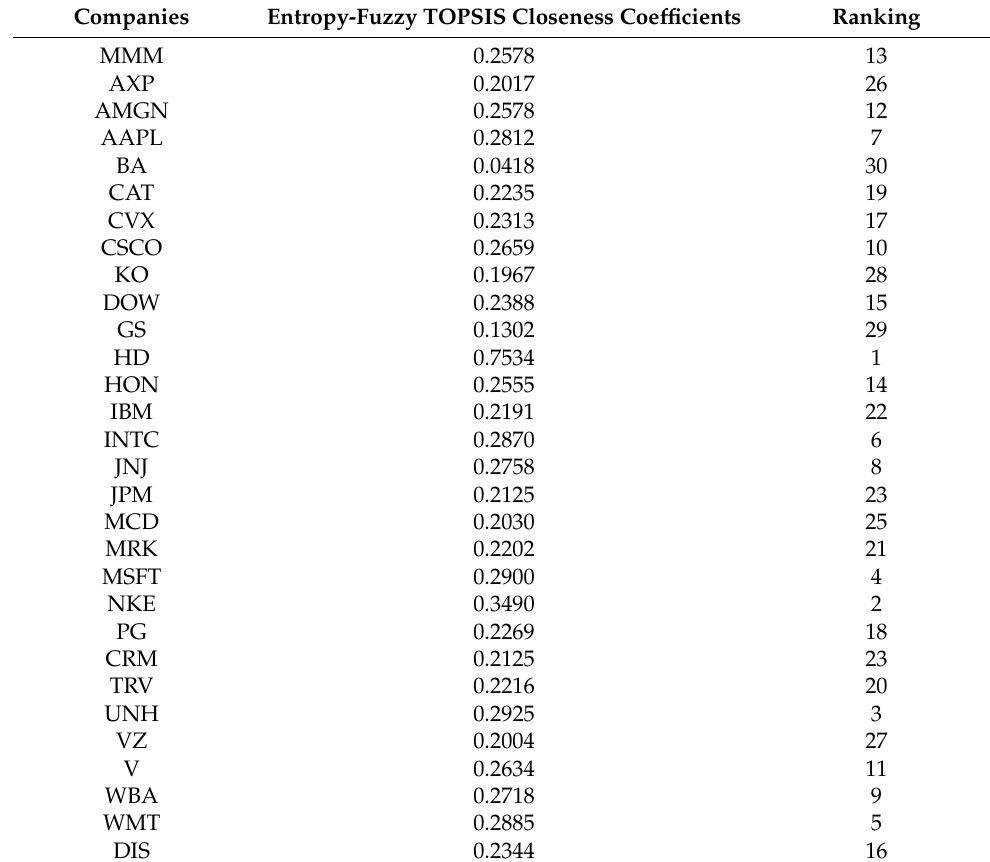
Table 10. The entropy-fuzzy TOPSIS closeness coefficients and ranking of companies.